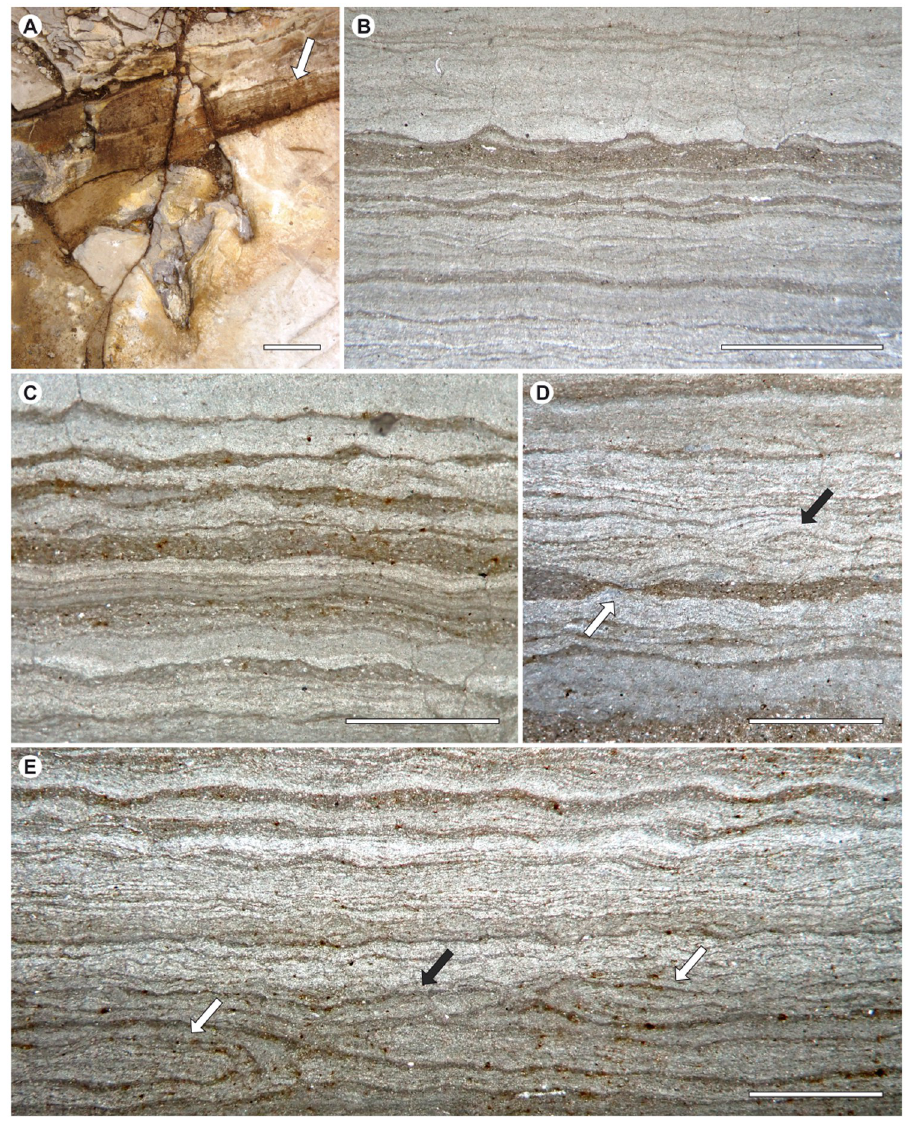
Fig 6. Magenta layer biolamination. (A) Lamination of limestones and footprint. (B) and (C) Wavy-crinkly structures of the internal lamination. (D) and (E) Overfolded mats, showing ‘tear in mat’ process (black arrows), and convolutions (white arrows). Scale bar in A, 10 cm; scale bar in B-E, 1 mm.